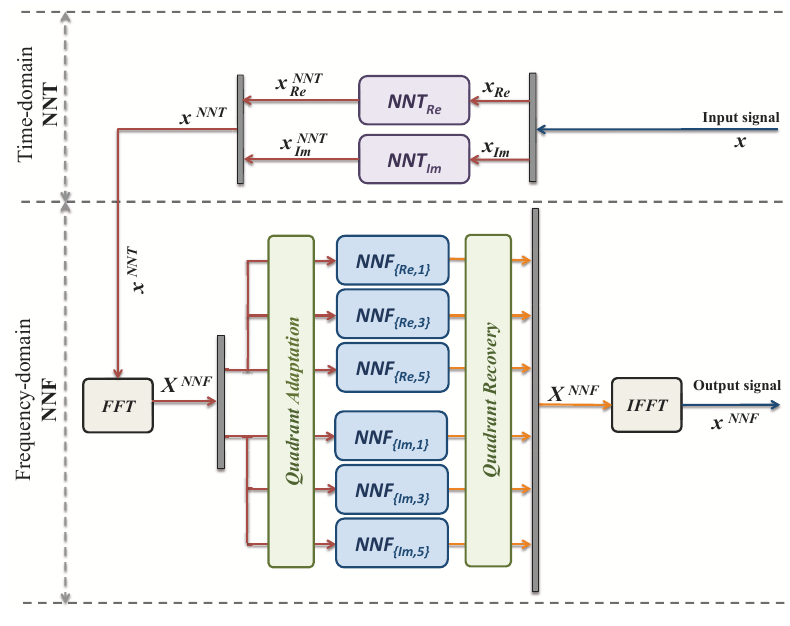
Figure 6. New time-domain and frequency-domain NN for DCM.